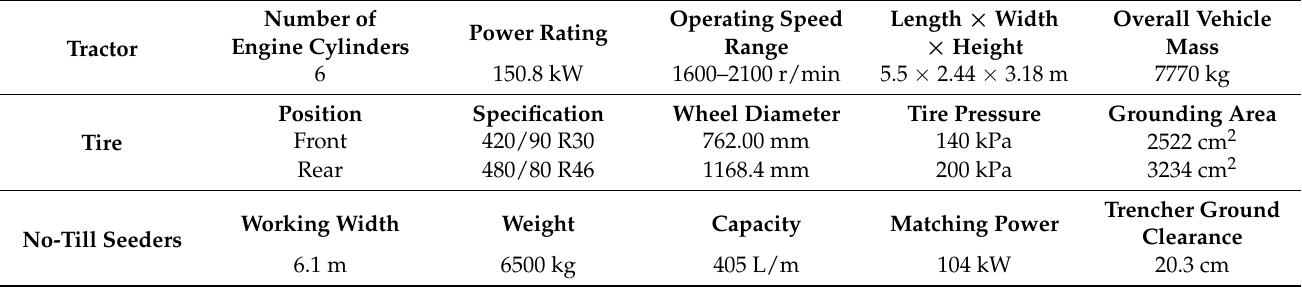
Figure 1. Overview of the experimental area. Table 1. Seeding unit